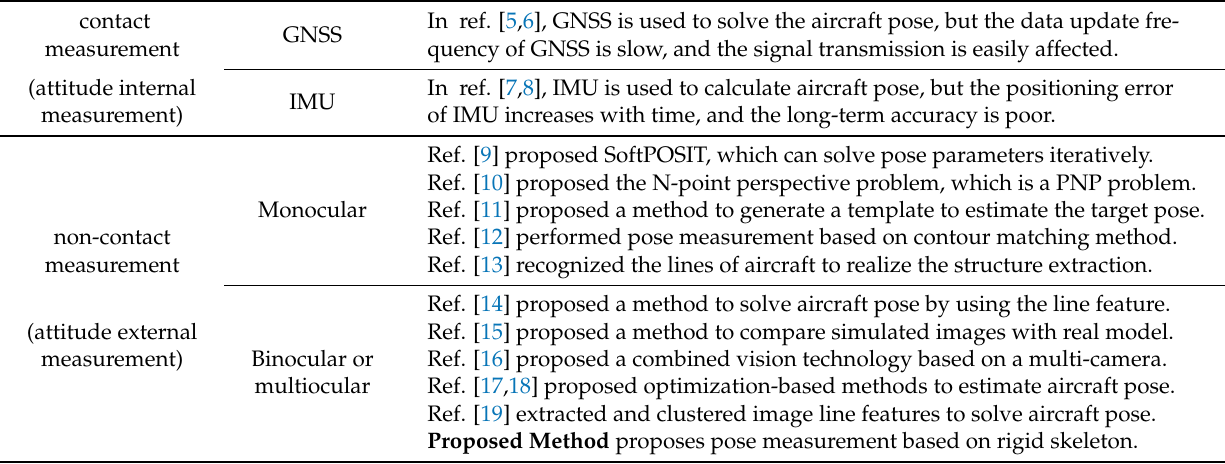
Table 1. Classification of pose measurement